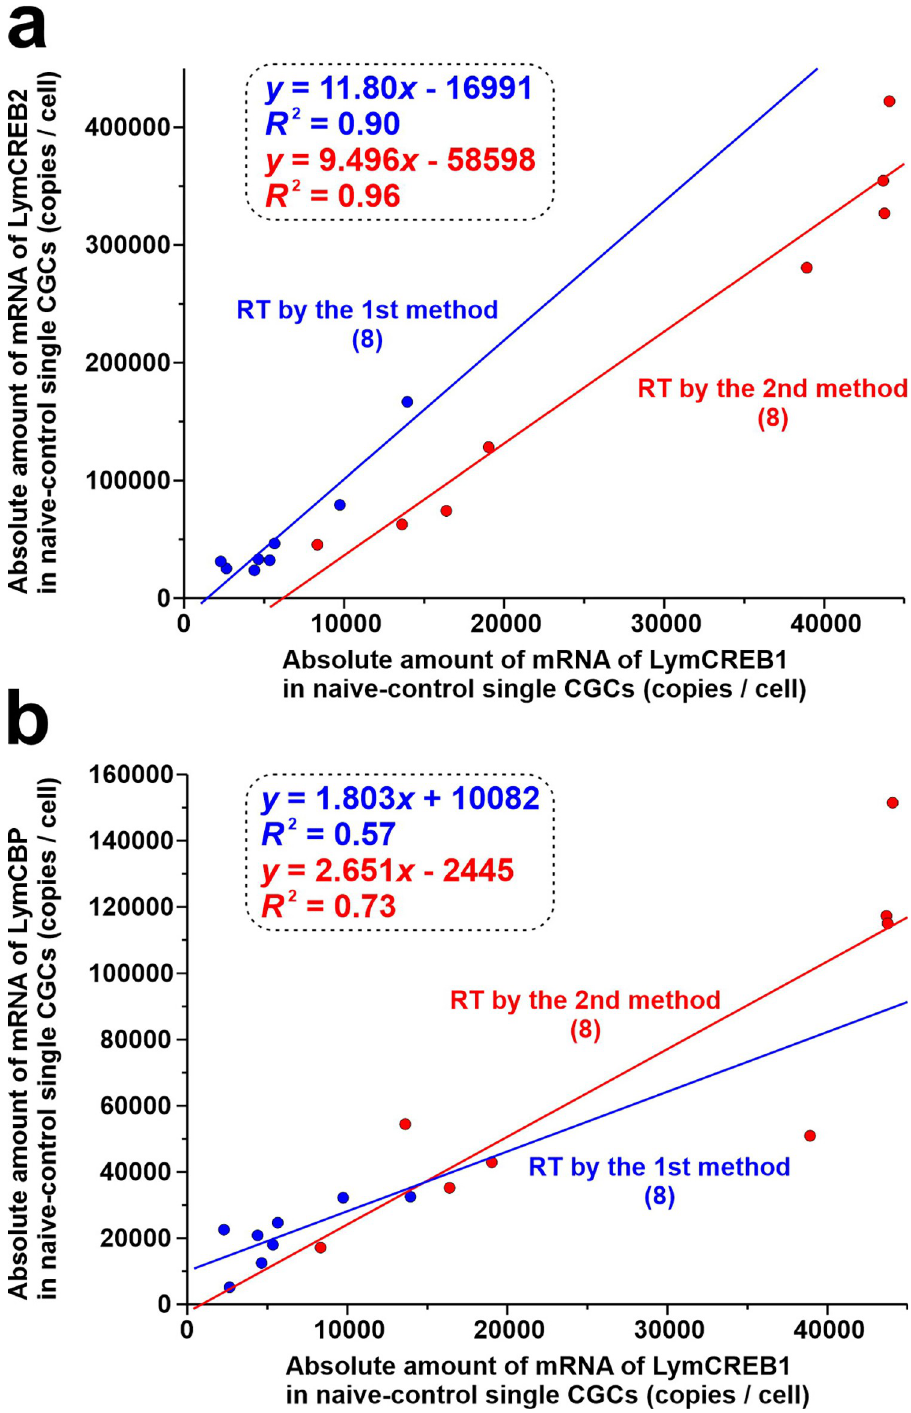
Fig 7. Linear regression analyses to evaluate the relationship between mRNA levels of LymCREB1 ( X axis) and LymCREB2 [ Y axis in (A)] and LymCBP [ Y axis in (B)] calculated by absolute quantification. The red dots and lines indicate samples prepared by RT method 1 and the blue dots and lines indicate samples prepared by RT method 2. The number of samples was 8 for each group. Equation and coefficient of determination ( R 2 values) of lines are shown in insets. Slopes and F -test results are summarized in Table 3. Statistical analyses suggested that the 2 regression lines are parallel in LymCREB2/LymCREB1 and LymCREB2/LymCBP [ p = 0.404 (A); p = 0.726 (B)].